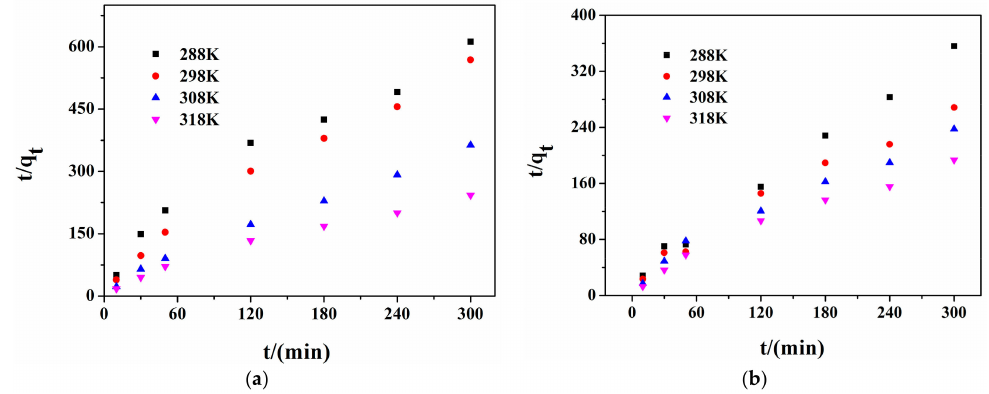
Figure 12. Effect of temperature on 1-naphthol adsorption on raw diatomite. ( a ) And calcined 450 ◦ C diatomite; ( b ) pseudo-second order adsorption kinetics plots.